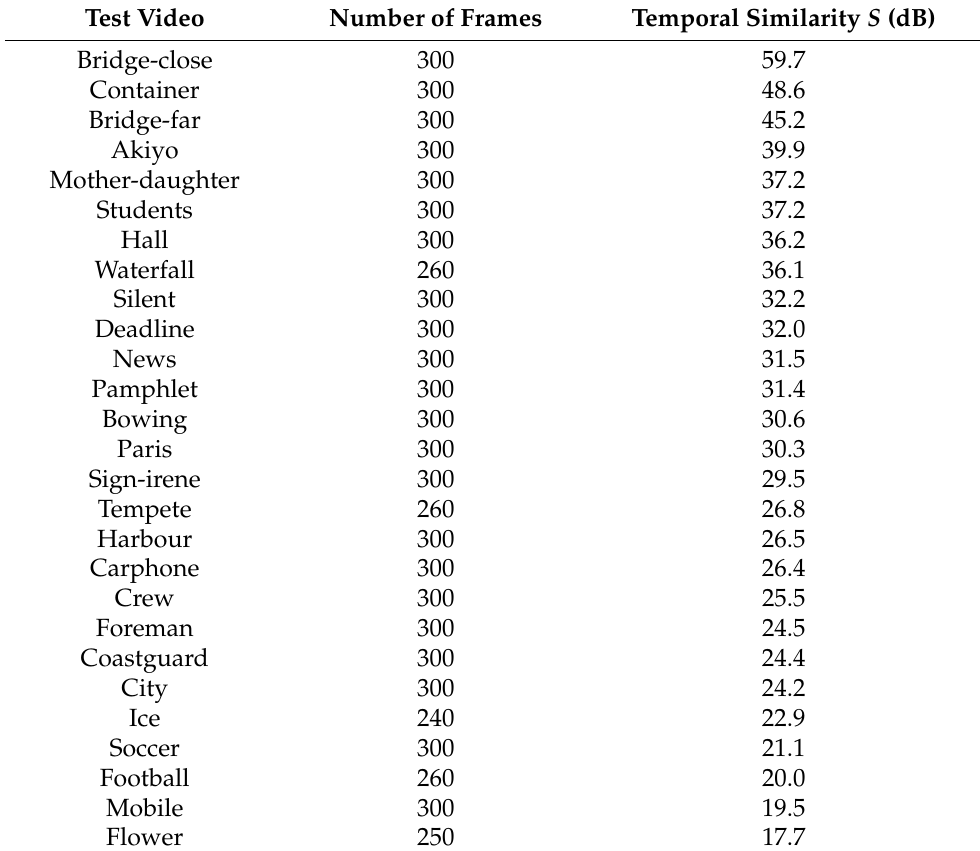
Table 4. Test video